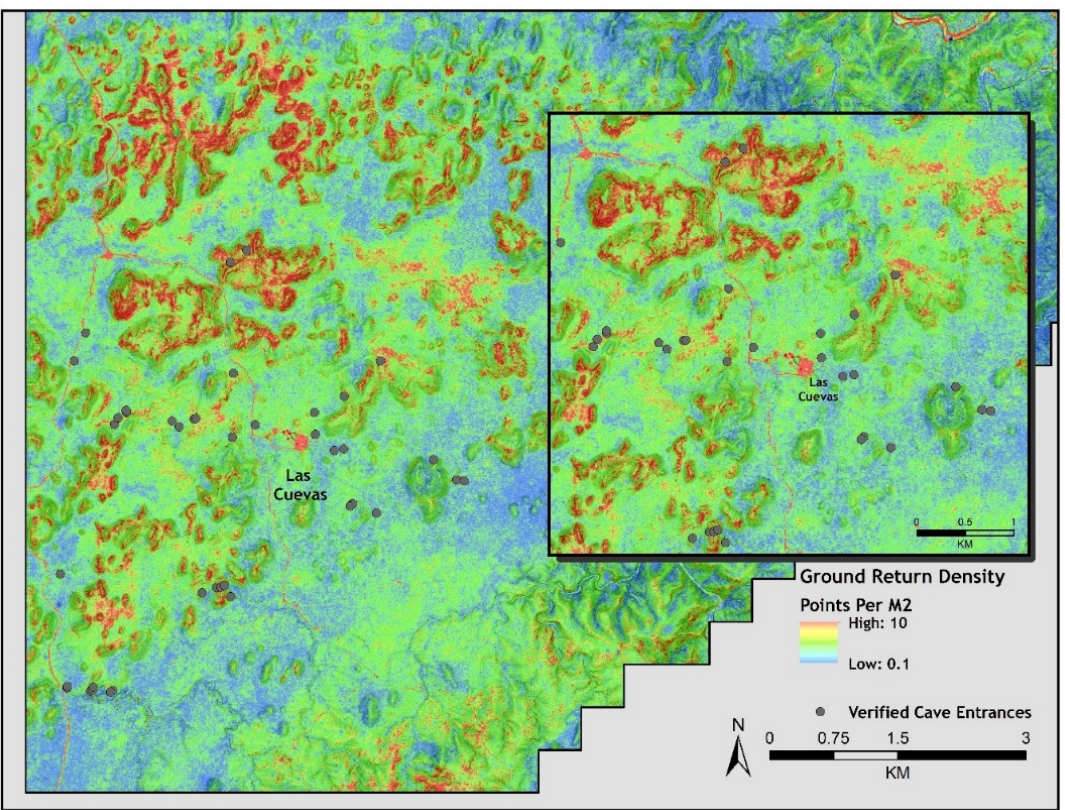
Figure 6. Map illustrating the density of LiDAR ground point returns correlated with topography.